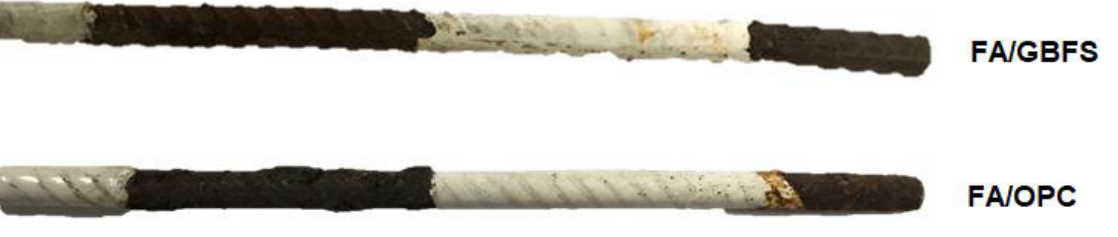
Table 4. Percentage loss of mass of the steels embedded in the concretes after the accelerated.